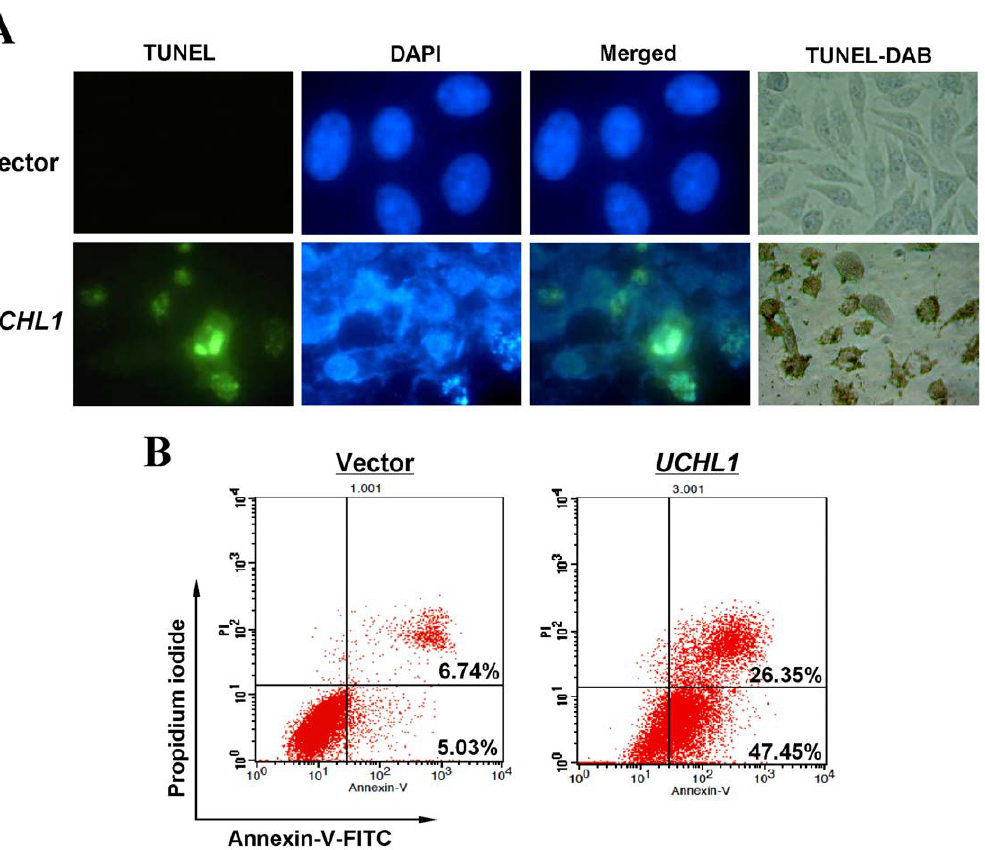
Figure 6. Detection of apoptosis induced by UCHL1 using TUNEL assay and Annexin V-FITC/PI staining in MB231 cells. (A) Apoptotic cells detected by TUNEL staining. (B) Induction of apoptosis detected by flow cytometric analysis with Annexin V-FITC and PI-staining.